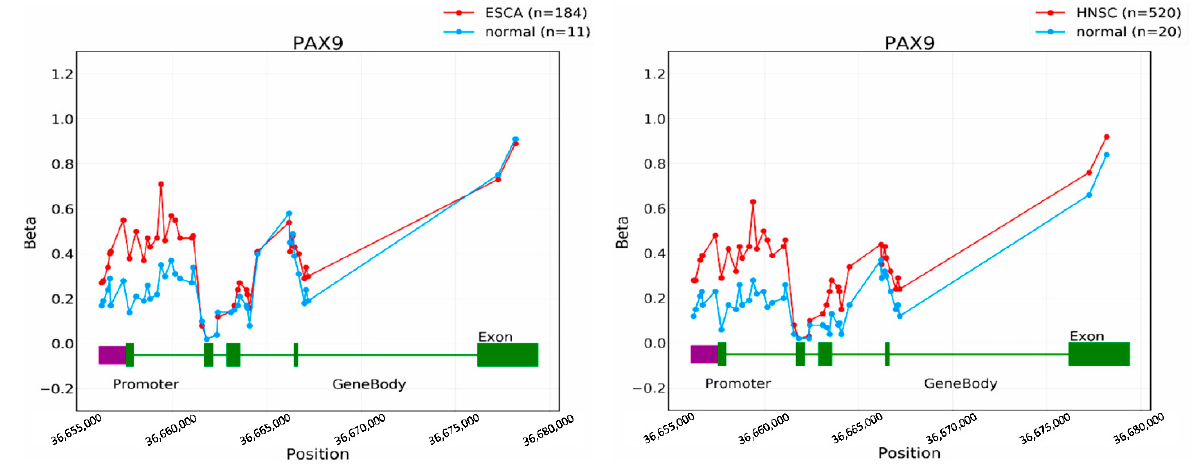
Figure 5. PAX9 promoter hypermethylation in esophageal carcinoma (ESCA) and head and neck squamous cell carcinoma (HNSCC) (www.oncodb.org) (accessed on 22 March 2022). The beta value indicates the methylation level.